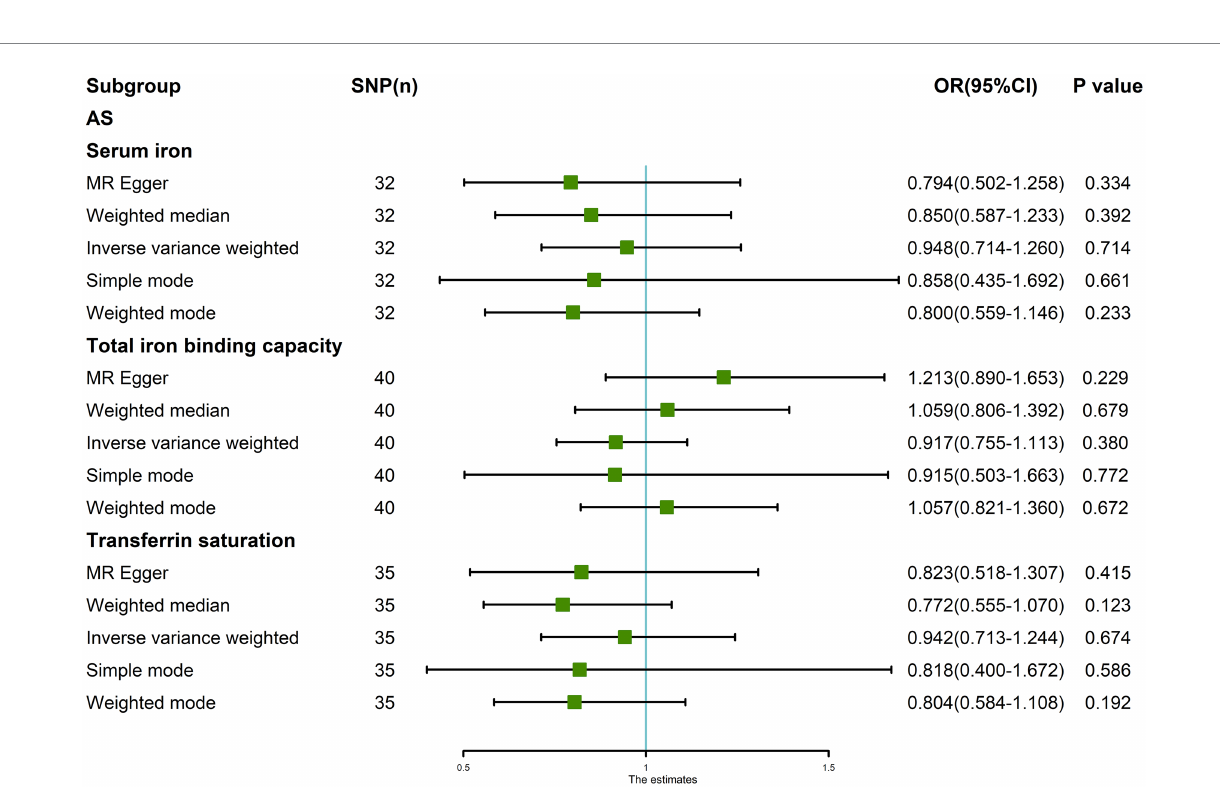
oxidative stress due to excessive reactive oxygen species (ROS) production via the Fenton reaction, leading to osteoblast damage and dysfunction (54, 55). This process affects bone metabolism in AS